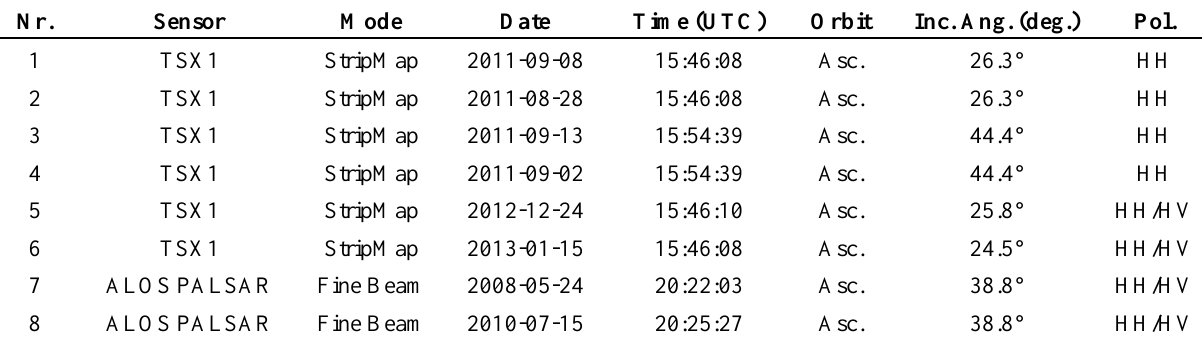
Table 1. List of SAR images of the study area. Inc. Ang., incident angle at scene center; Pol., polarization; deg., degrees; Asc.,